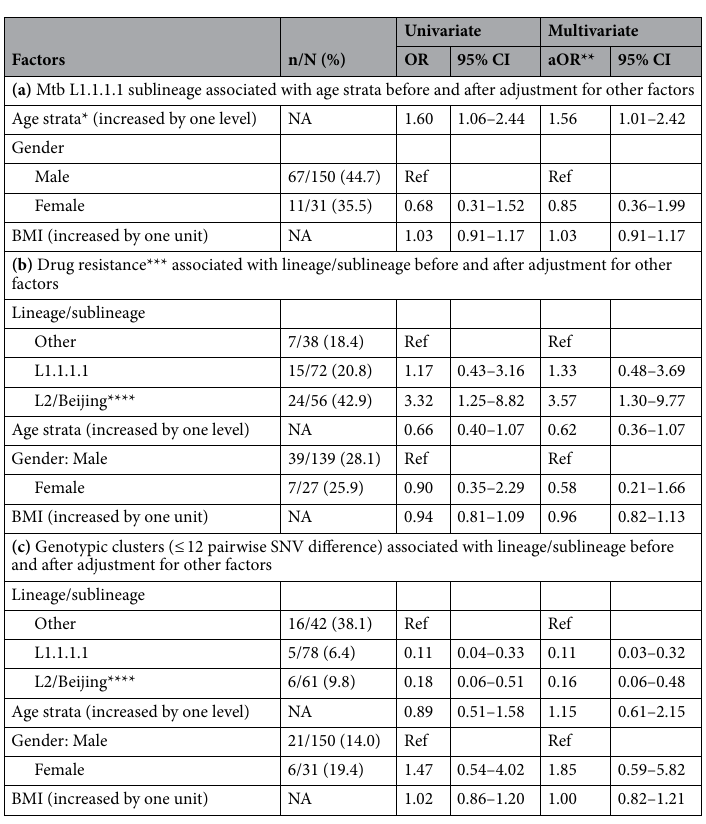
Table 2. Univariate and multivariate analyses using logistic regression models. BMI body mass index, NA not applicable, Mtb Mycobacterium tuberculosis , SNV single nucleotide variant. *Age strata: < 35.0,